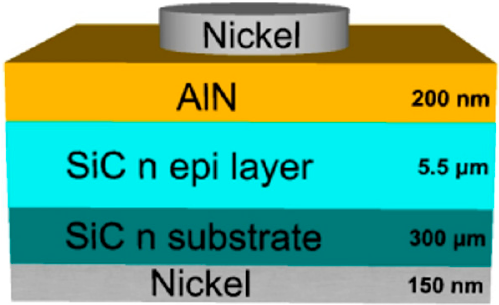
Figure 1. Structure of an aluminum nitride (AlN) Schottky barrier diode.